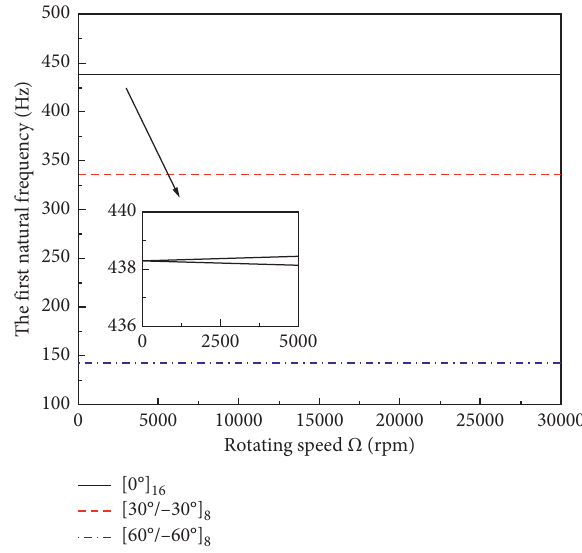
Figure 3: Variation of the first natural frequency with rotating speed at different ply angles.